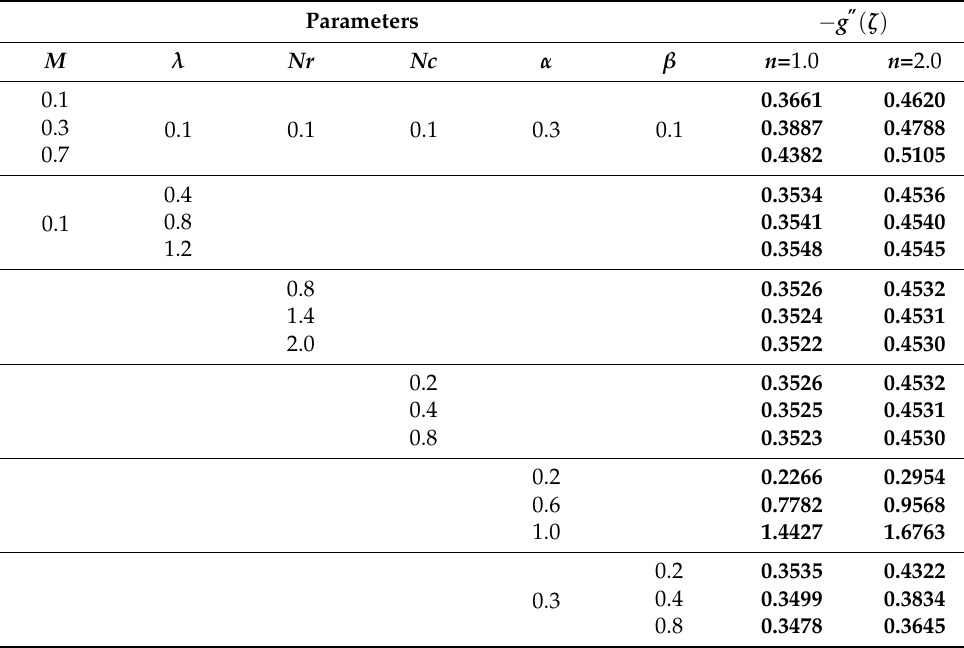
Table 2. Effect of flow factors over velocity component − g (cid:48)(cid:48) ( ζ ) at ζ =